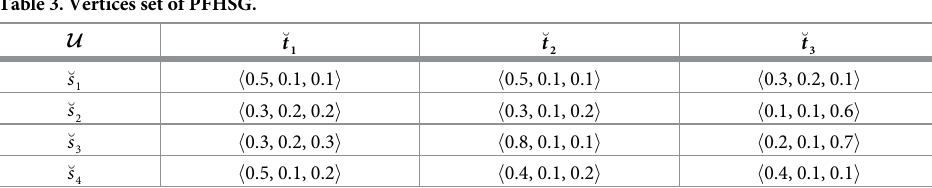
Table 3. Vertices set of